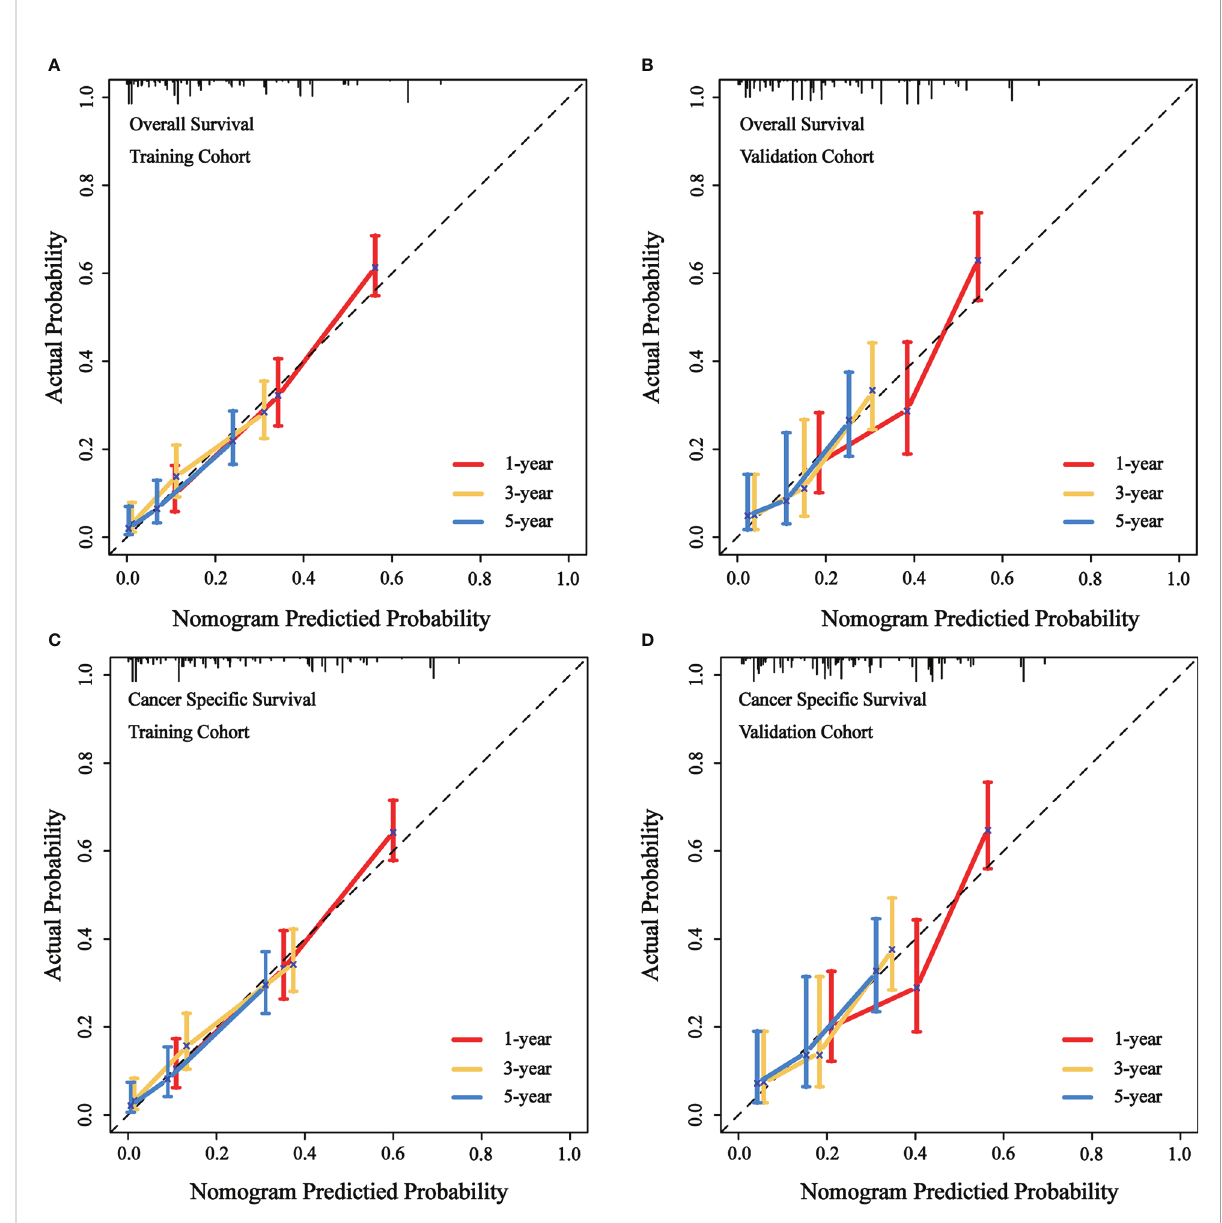
FIGURE 3 Calibration curves of the nomograms to predict OS and CSS at 1-, 3-, 5-year for patients with GBMAC. (A) Calibration curve of the nomogram to predict OS at 1-, 3-, 5-year in training cohort. (B) Calibration curve of the nomogram to predict OS at 1-, 3-, 5-year in validation cohort. (C) Calibration curve of the nomogram to predict CSS at 1-, 3-, 5-year in training cohort. (D) Calibration curve of the nomogram to predict CSS at 1-, 3-, 5-year in validation cohort. The horizontal axis of the nomogram represents the expected value, while the vertical axis represents the observed